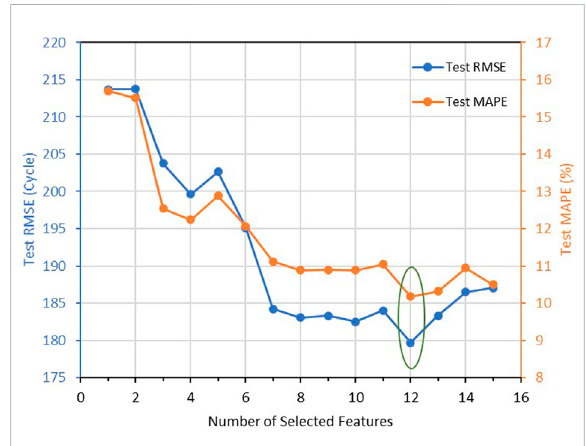
FIGURE 6 Test error (RMSE and MAPE) changes with different selected features. Selecting 12 features provides the best regression result.